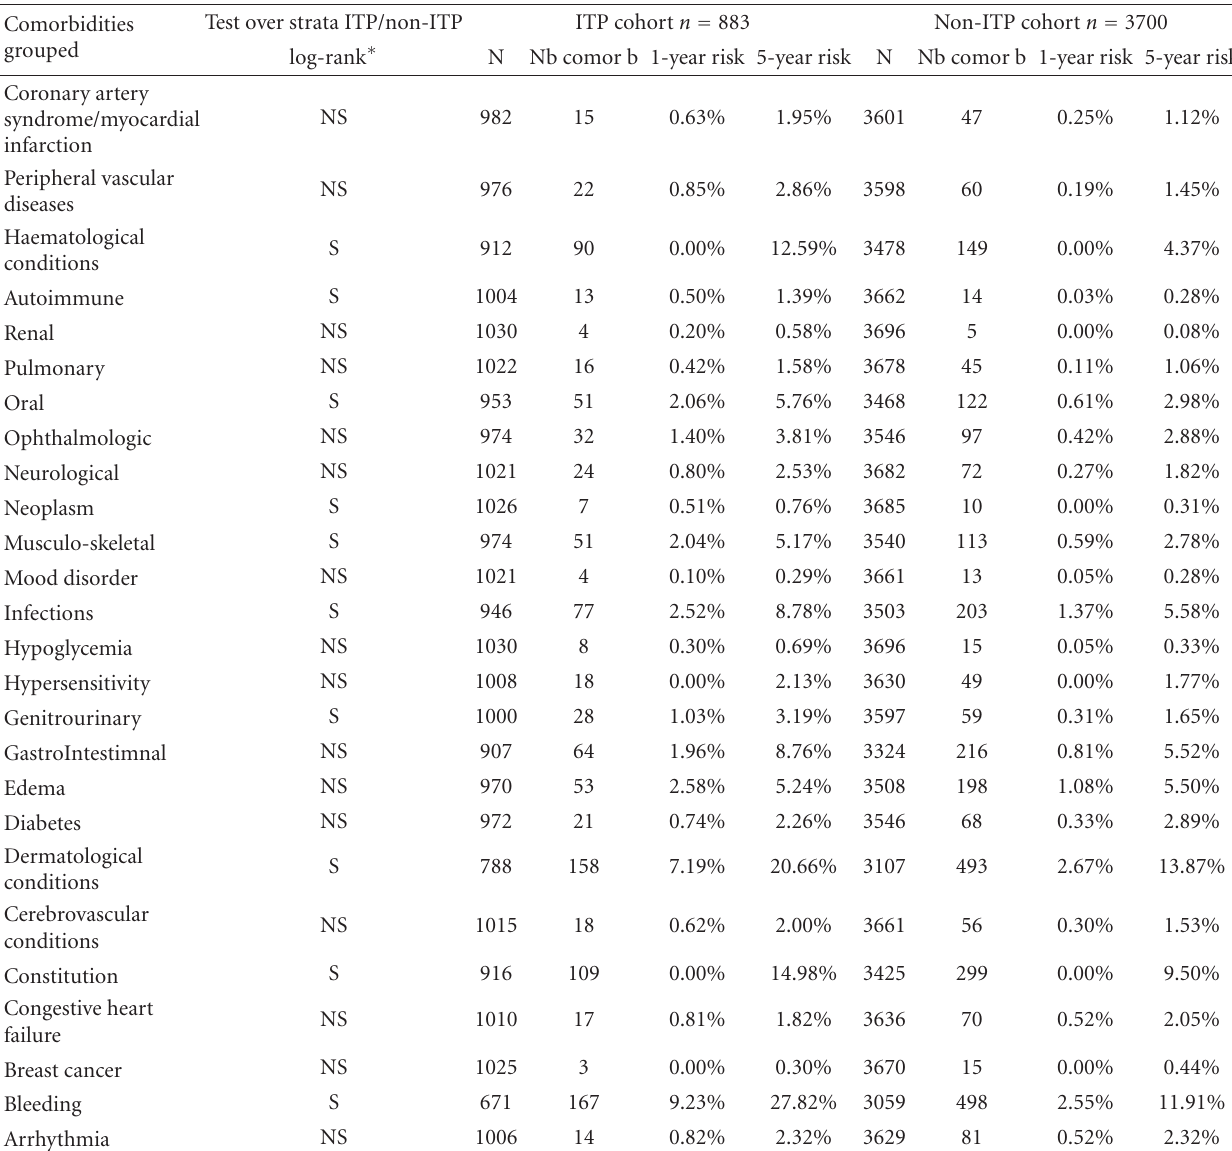
Table 7: One- and five-year risk of 26-grouped comorbidities and tests over strata after index.